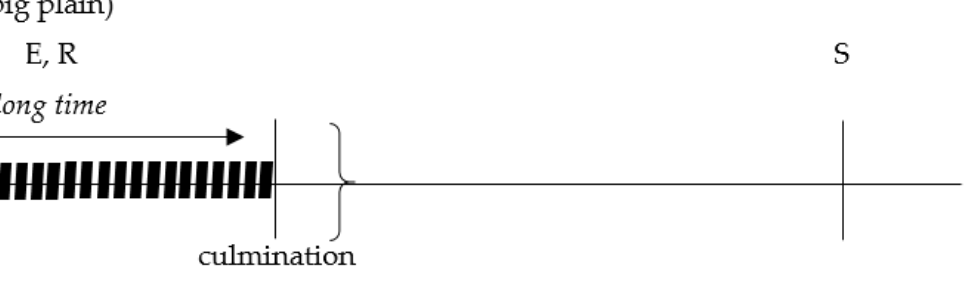
Figure 3. ’He crossed that big plain [for a long time]’.